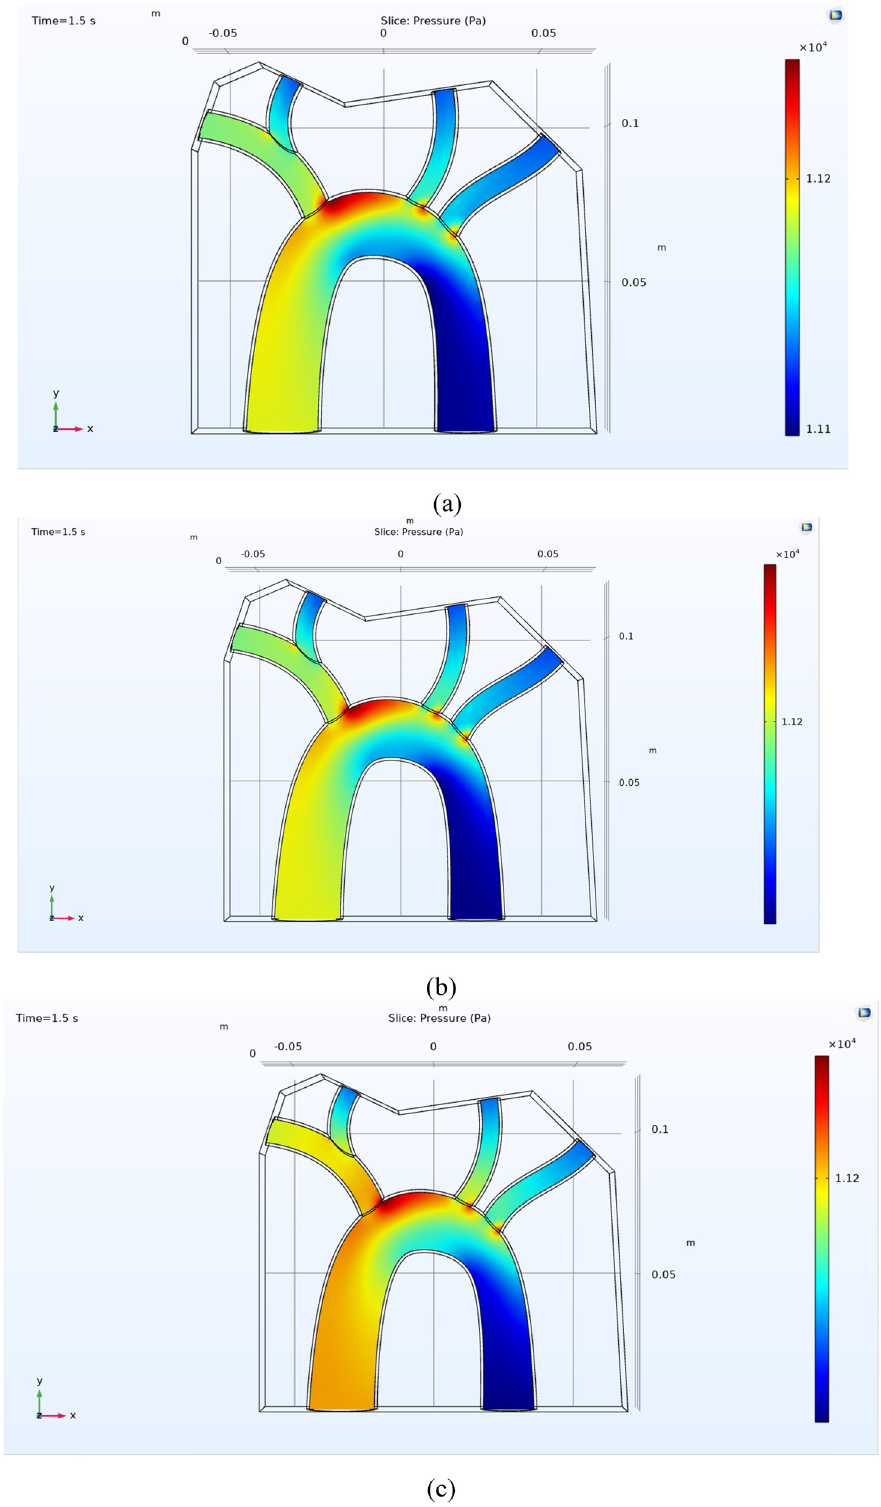
Figure 5: Pressure contour ( a ) 0.005, ( b ) 0.01, ( c ) 0.02, ( d ) 0.03, ( e ) 0.04, ( f ) 0.05, ( g ) 0.06, ( h ) 0.07, ( i ) 0.08, ( j ) 0.09, ( k ) 0.1, all in